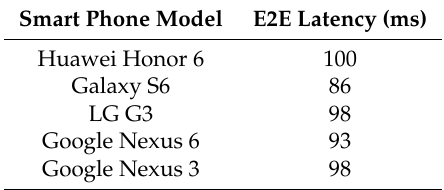
Table 1. 95 percentile of E2E Latency for different